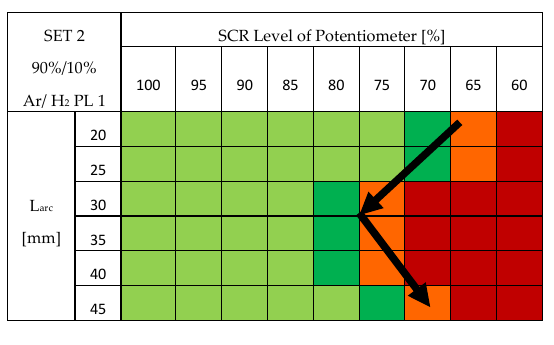
Table 10. The trend of lower stabilities at mid-range arc lengths.